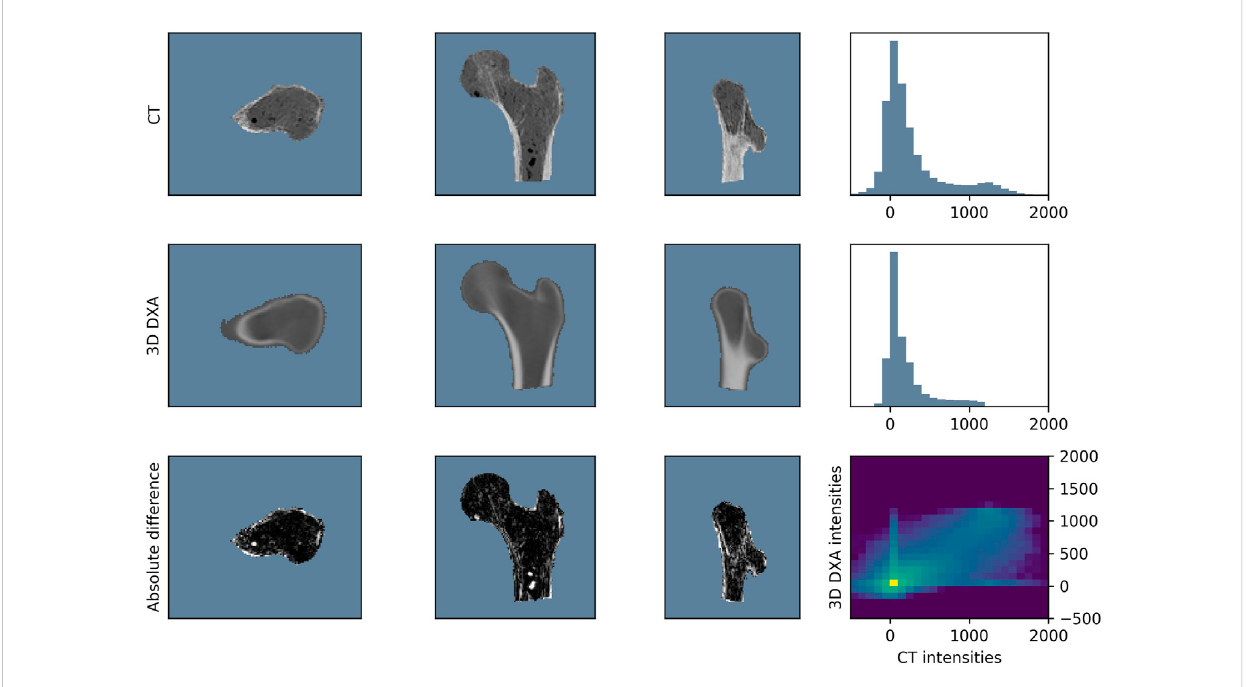
FIGURE 5 Example with average registration performance (MI = 0.10, r 2 = 0.52, dice = 0.91).